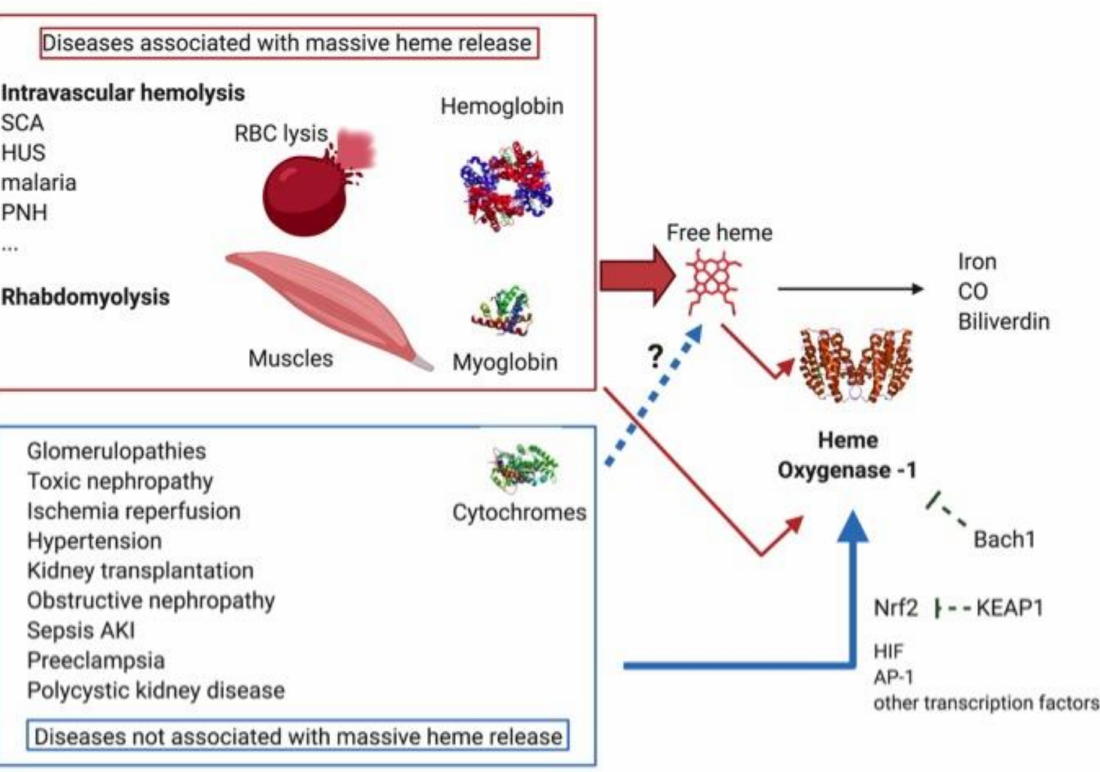
Figure 3. Schematic description of HO-1 regulation in renal pathologies. Plain arrows: proved link, Dotted arrows: suspected link, AKI: acute kidney injury, SCA: sickle cell anemia, HUS: hemolytic uremic syndrom, PNH: paroxysmal nocturnal haemoglobinuria (Created with